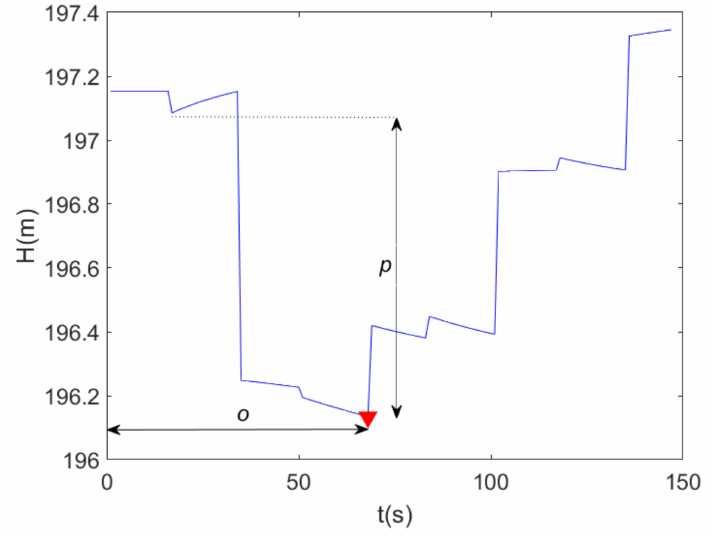
Figure 3. Pressure drop amplitude ( p ) and its time delay during a pipe burst ( o ) at certain sensor (red triangle). Axes are in seconds and water column meters for total